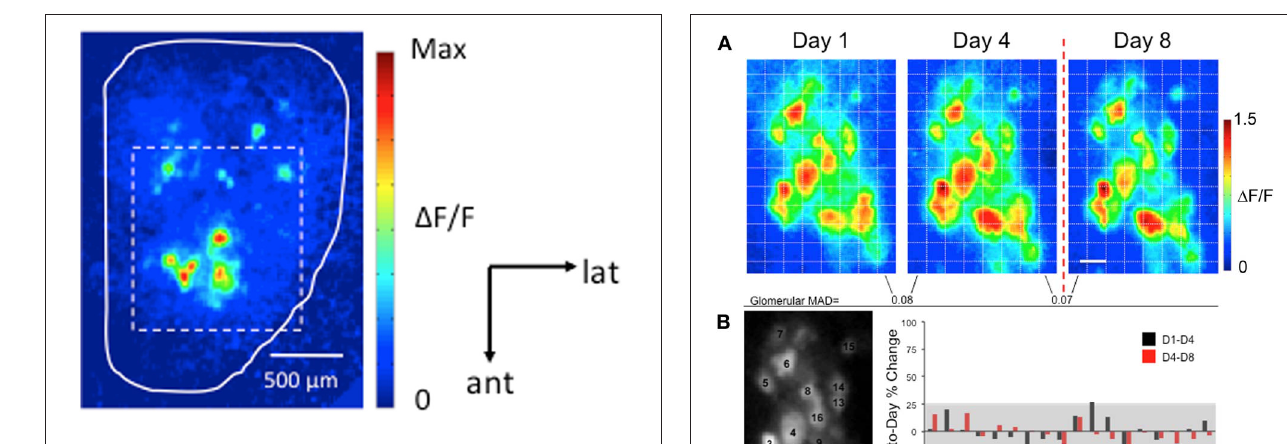
FIGURE 2 | Odor-evoked G-CaMP2 Ca 2 + responses imaged in the olfactory bulb. Dorsal view of a pseudo-color response map induced by methyl valerate (0.25% s.v.). The visible region of the dorsal bulbar surface under 10 × magnification is outlined by the dashed white line. Across all animals ( n = 22 mice, 327 glomeruli), 0.25% MV activated an average of 14 . 9 ± 3 . 6 glomeruli located on the anterior-dorsal region of the OB with an average amplitude of 5 . 0 ± 1 . 6% (cid:2) F/F. Scale bar: 500 μ m.